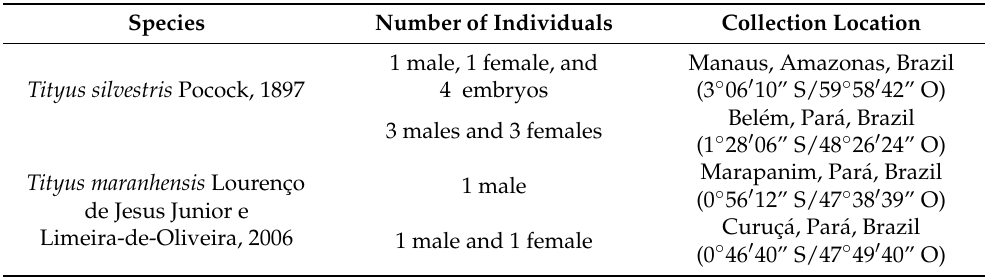
Table 1. General data about the specimens sampled in this study. Species Number of Individuals Collection Location 1 male, 1 female, and Tityus silvestris Pocock, 1897 4